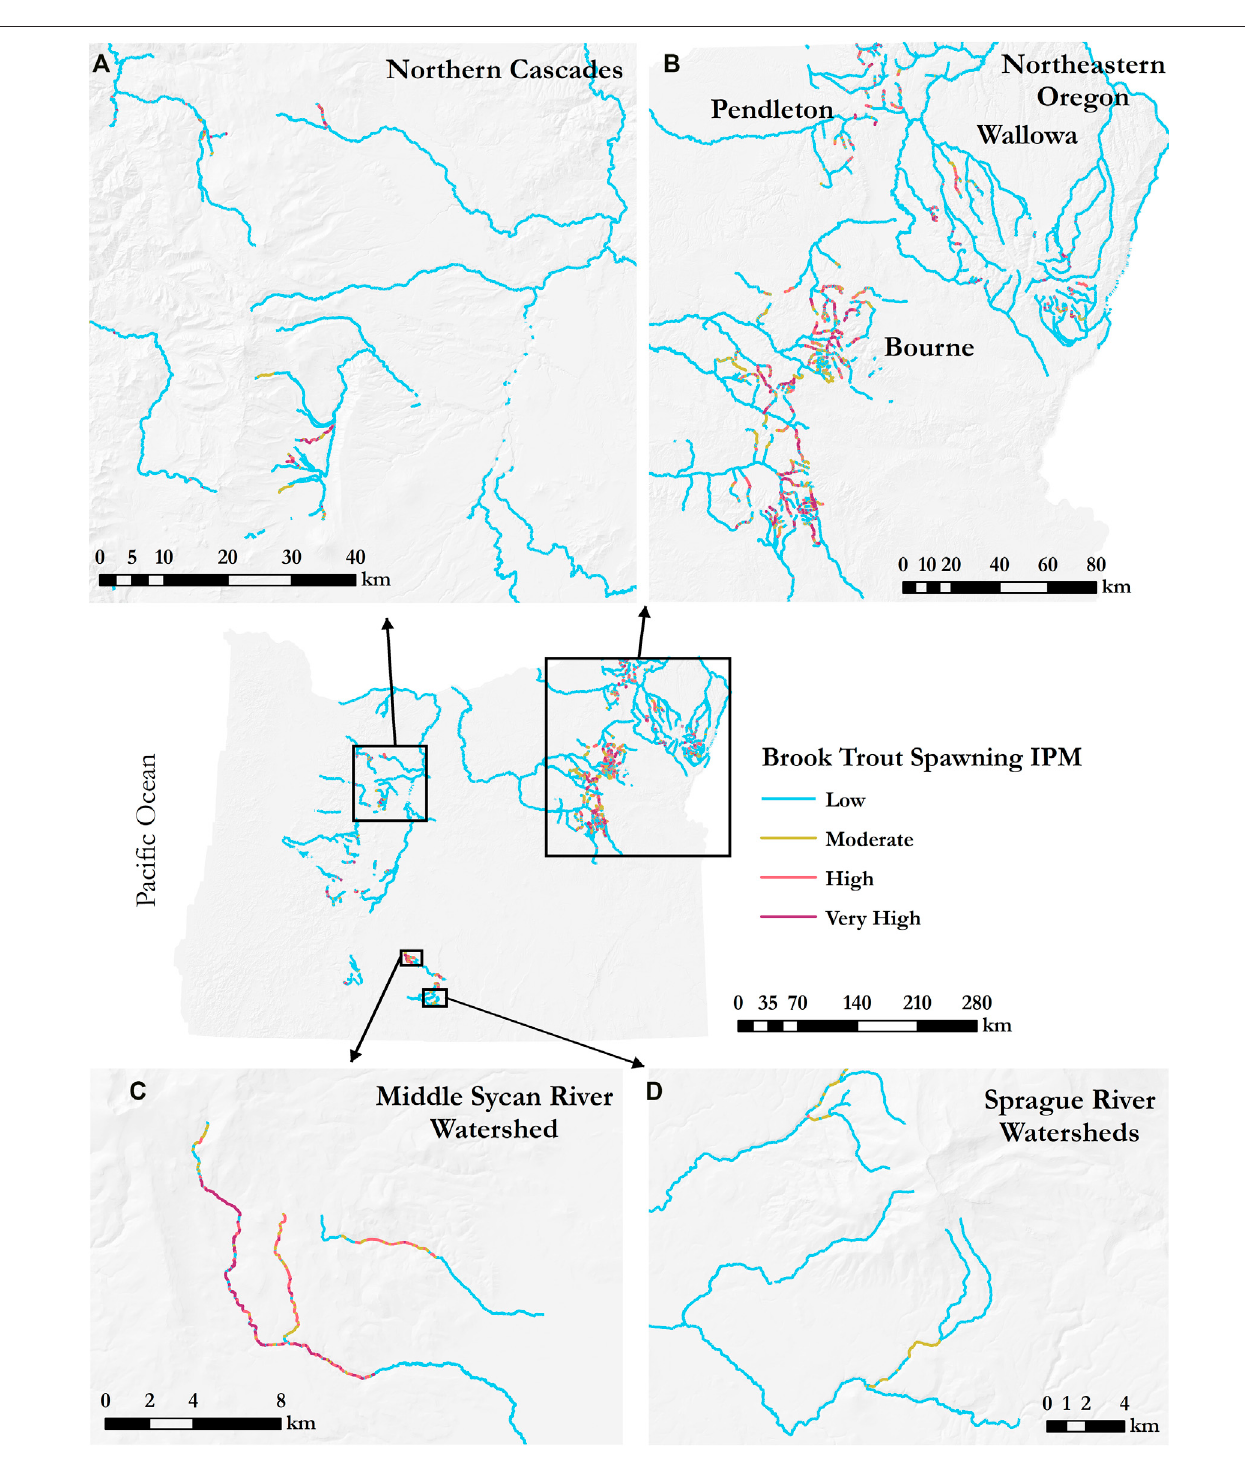
FIGURE 5 | Brook trout spawning intrinsic potential in all bull trout habitat types. Selected regions in (A) – (D) illustrate major areas of habitat overlap including (A) Northern Cascades, (B) Northeastern Oregon, (C) Middle Sycan River, and (D) Sprague River.